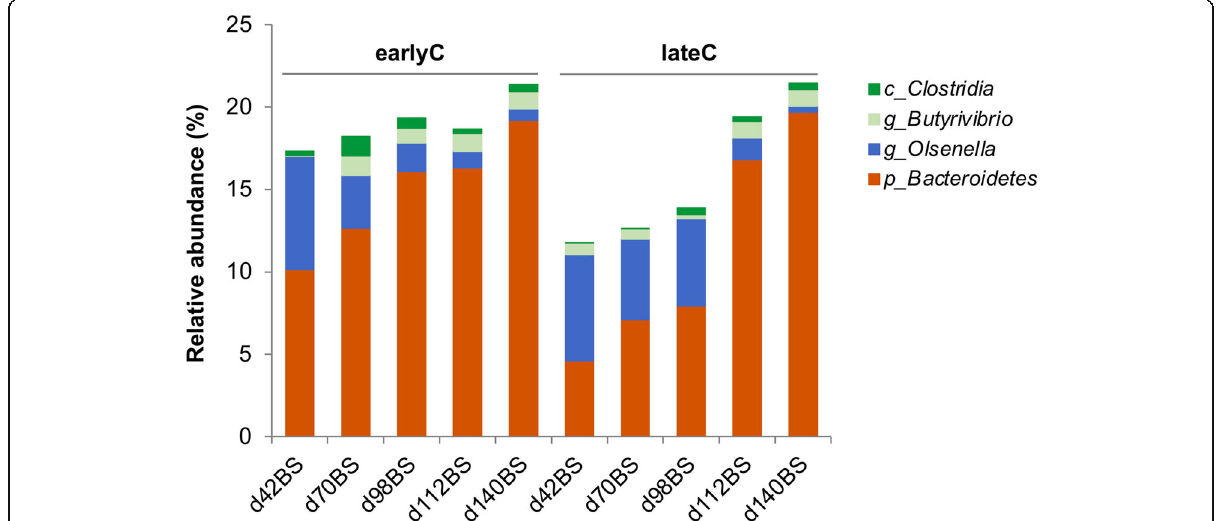
Fig. 5 Average relative abundances of RS bacterial genus-level taxa in BS samples of different weaning groups of calves. Each bar represents an average value for animals at each age group-weaning period combinations: day 42BS (6 & 5 animals), day 70BS (11 & 12 animals), day 98BS (25 & 21 animals), day 112BS (21 & 23 animals) and day 140BS (24 & 18 animals) for earlyC and lateC groups respectively. Only taxa that showed significant differences ( p ≤ 0.05) between the two weaning groups in a given sampling day are